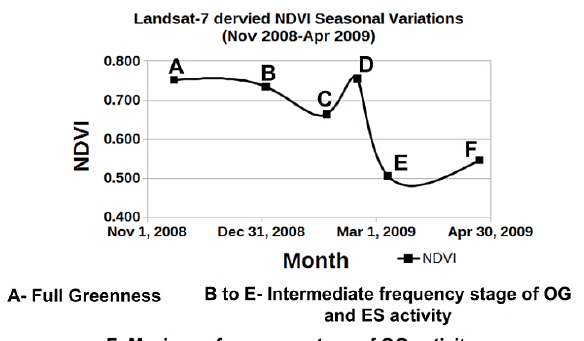
Figure 3: Landsat-7 derived NDVI trajectories along with phenological activities from Nov 2008 to Apr 2009 OG: Onset of Greenness (leaf flush durtation) and ES: End of Senescence (leaf fall duration)